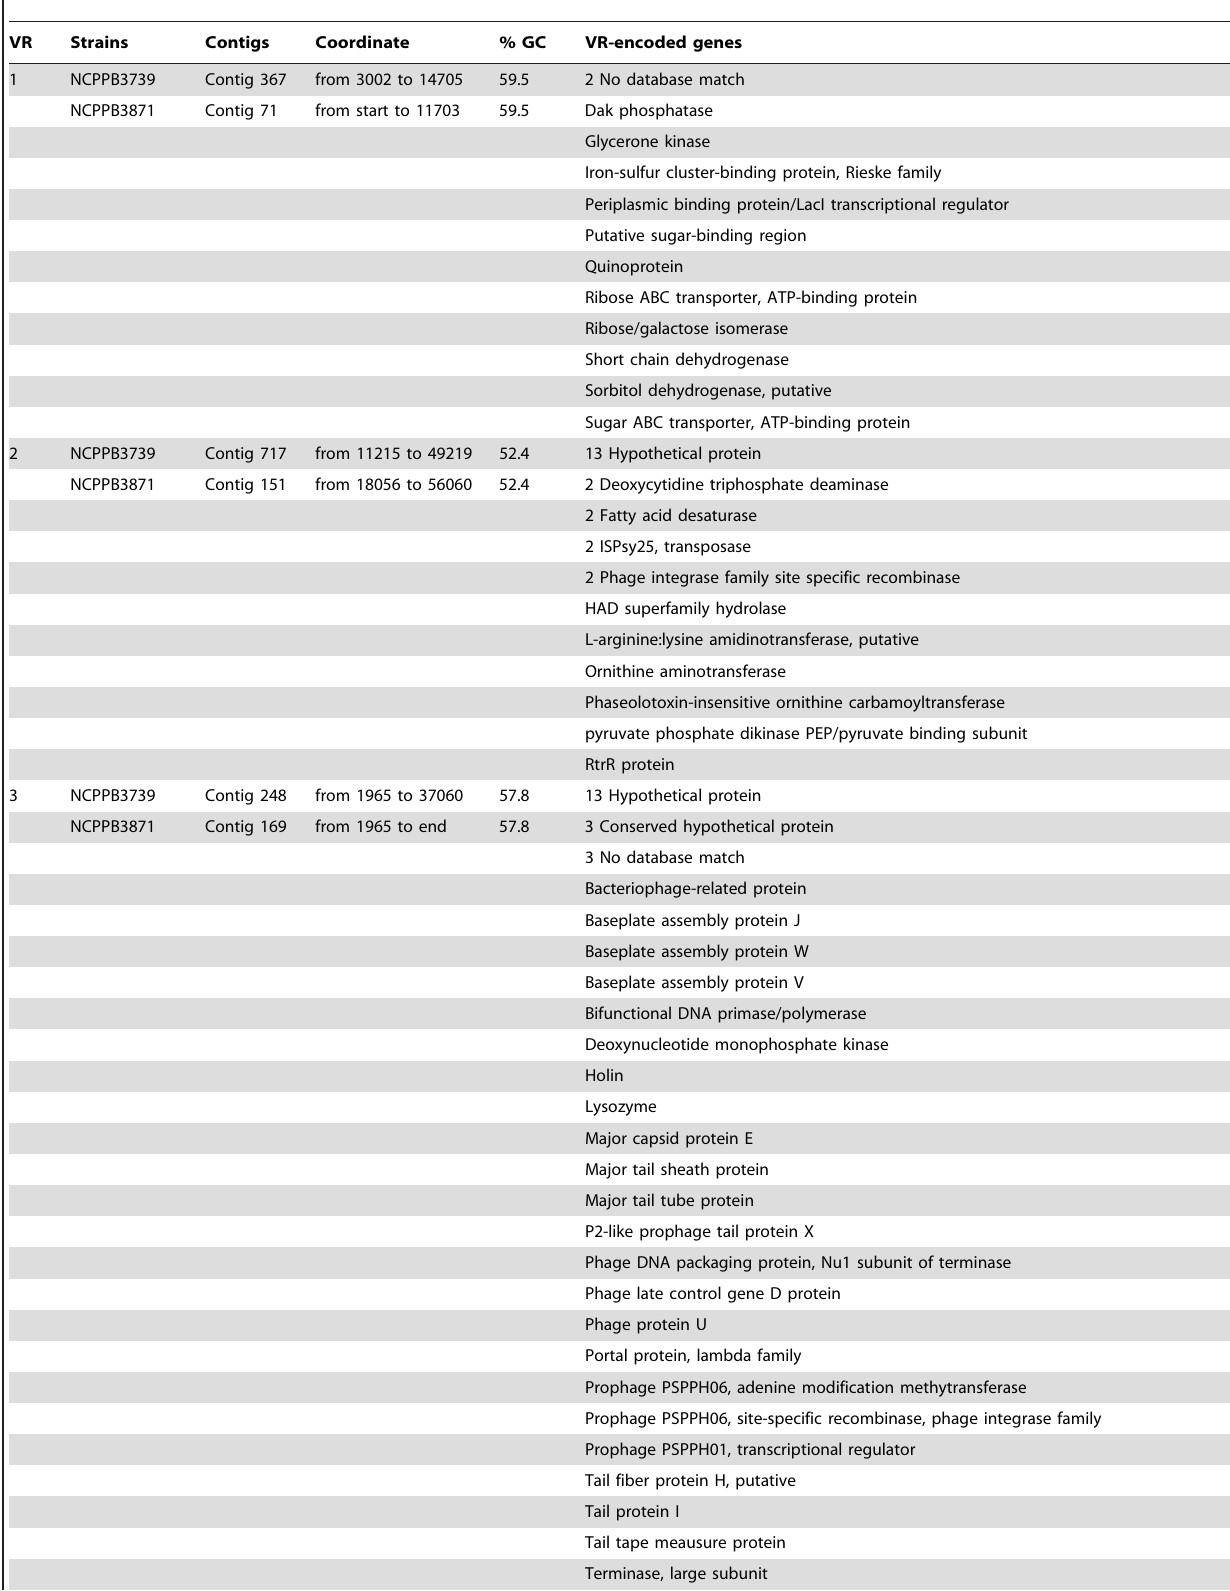
Table 3. Variable regions (VR) found in the draft genomes of J- Psa (NCPPB 3739) and I- Psa (NCPPB 3871) compared with I2- Psa (CRA FRU 8.43) draft